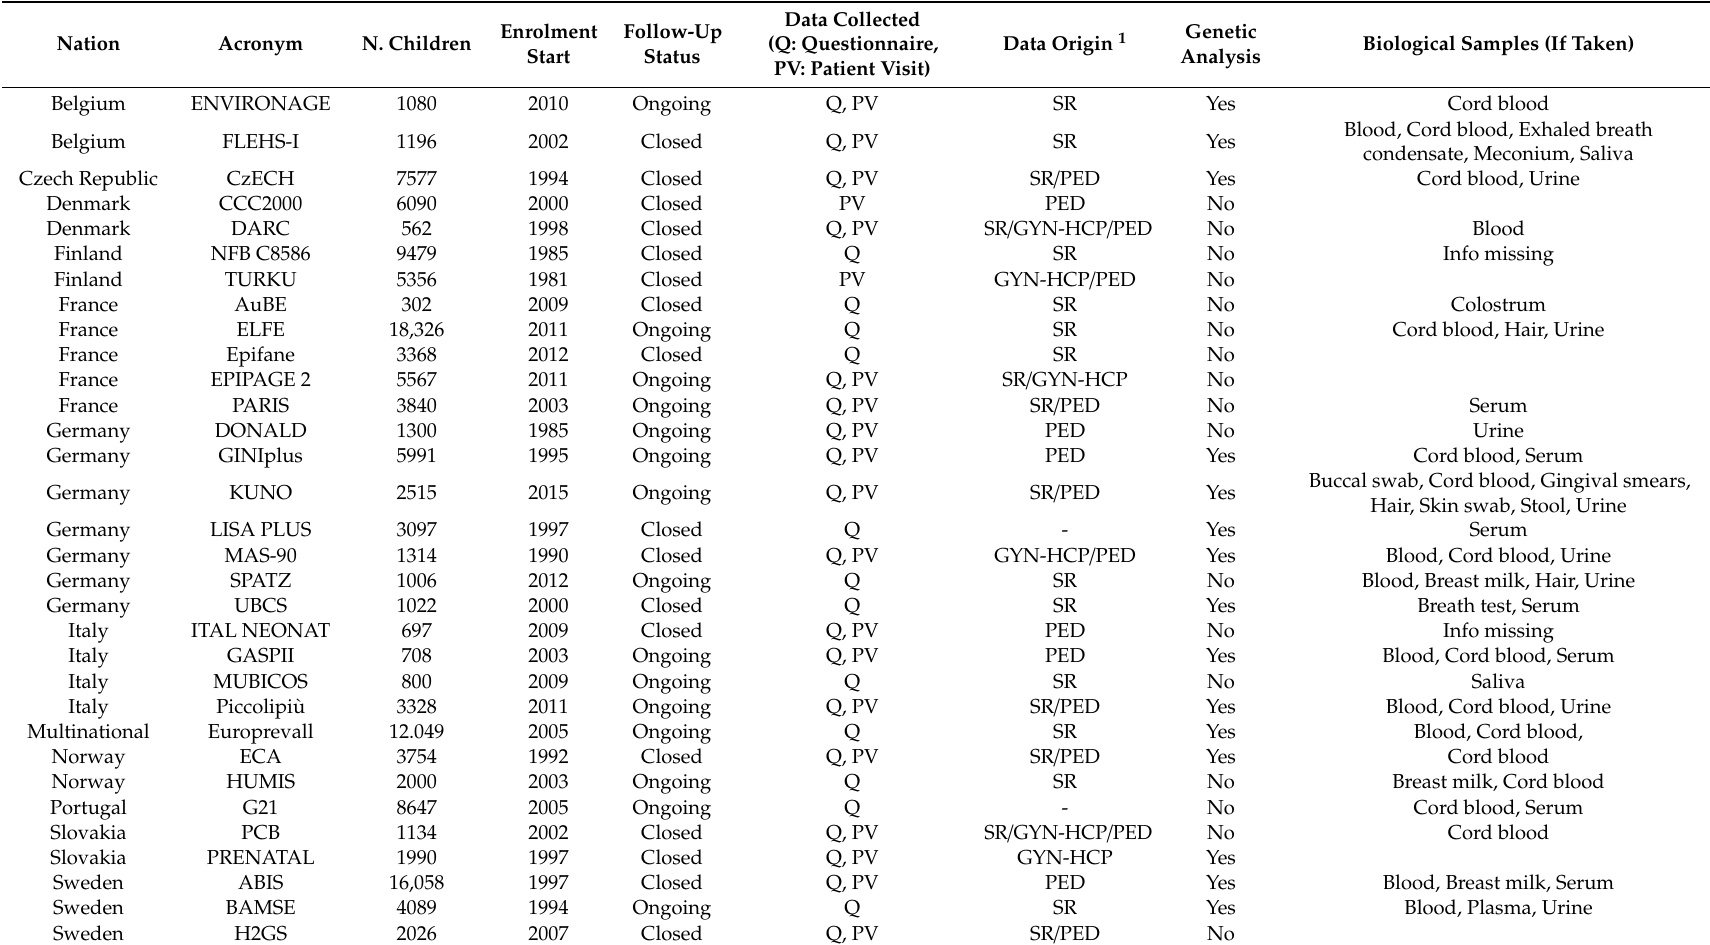
Table 1. The 45 European birth cohorts